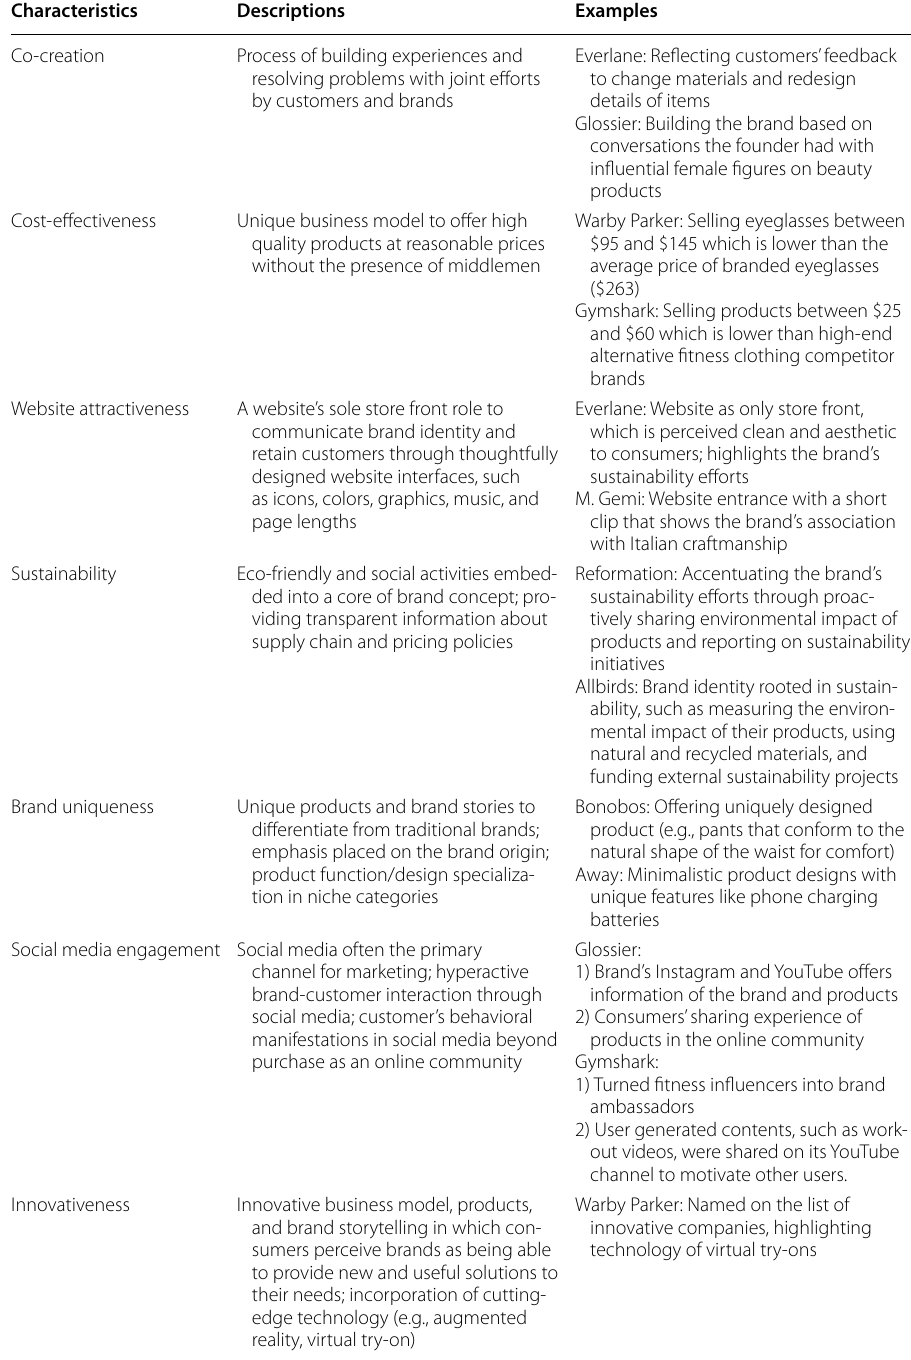
Developed by authors based on literature review and